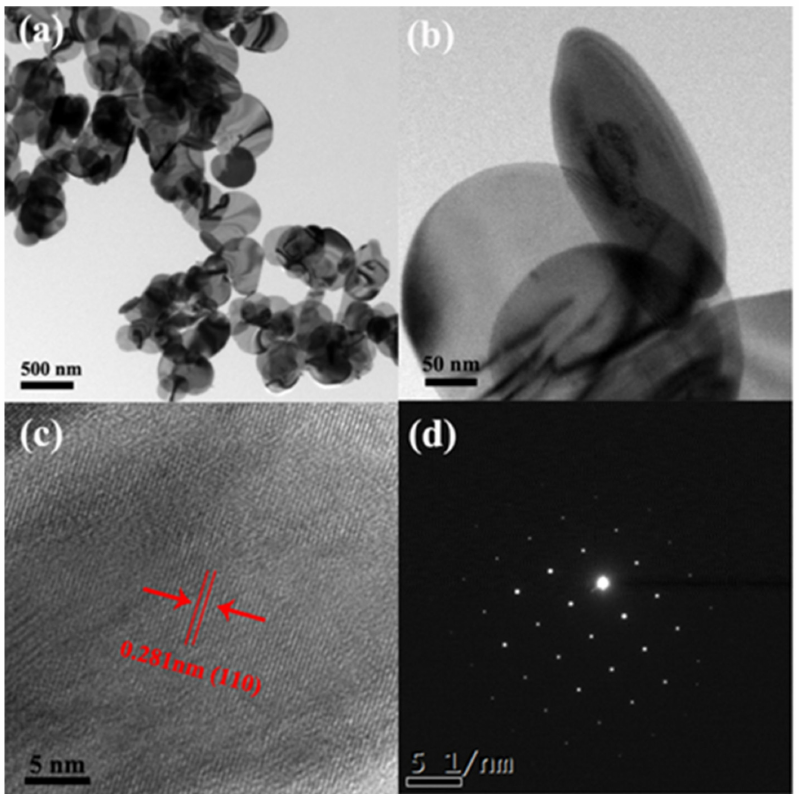
Figure 3. ( a , b ) TEM; ( c ) HRTEM images; and ( d ) SAED patterns of BiOBr 0.15 I 0.85 nanosheets with X =